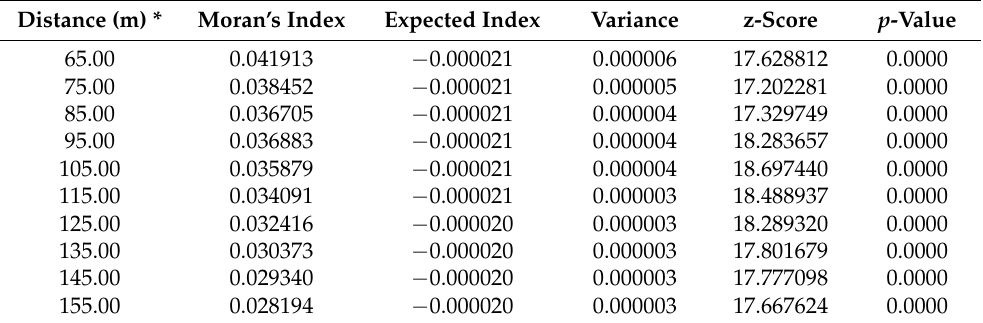
Table 3. The global Moran’s I summary by distance as calculated by the incremental spatial autocor- relation